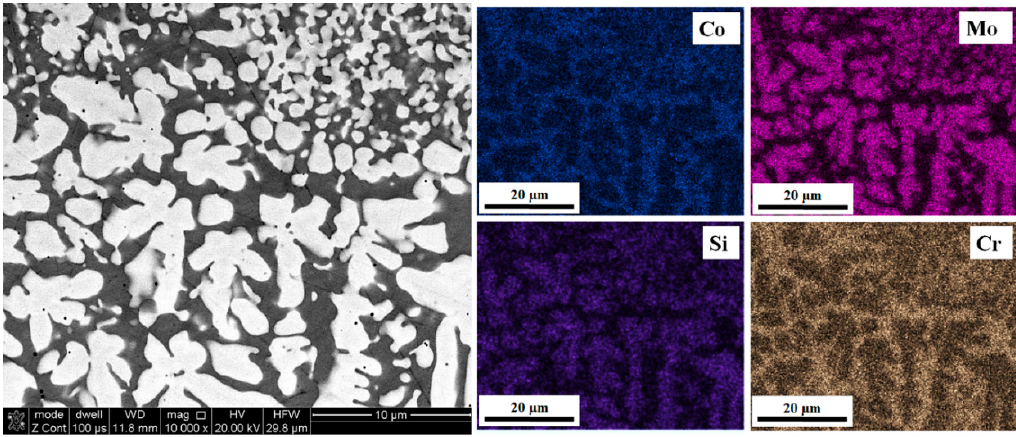
Figure 6. Elemental distribution maps for the T-800 coatings.